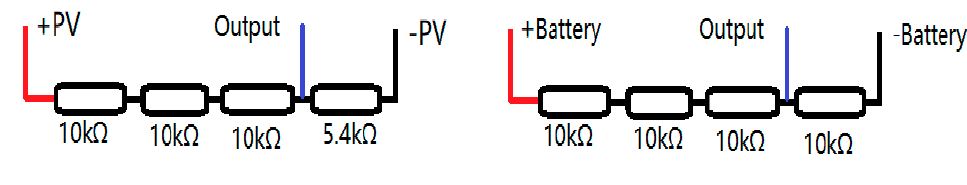
Figure 7. Voltage divider.